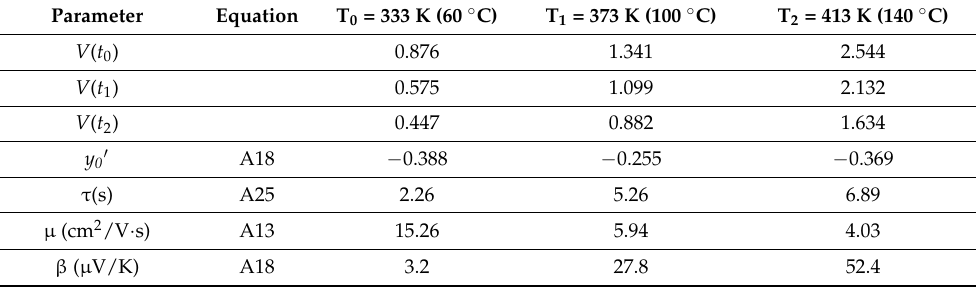
Table 7. Measured voltage and basic calculated parameters of the low-resistance AZO film.